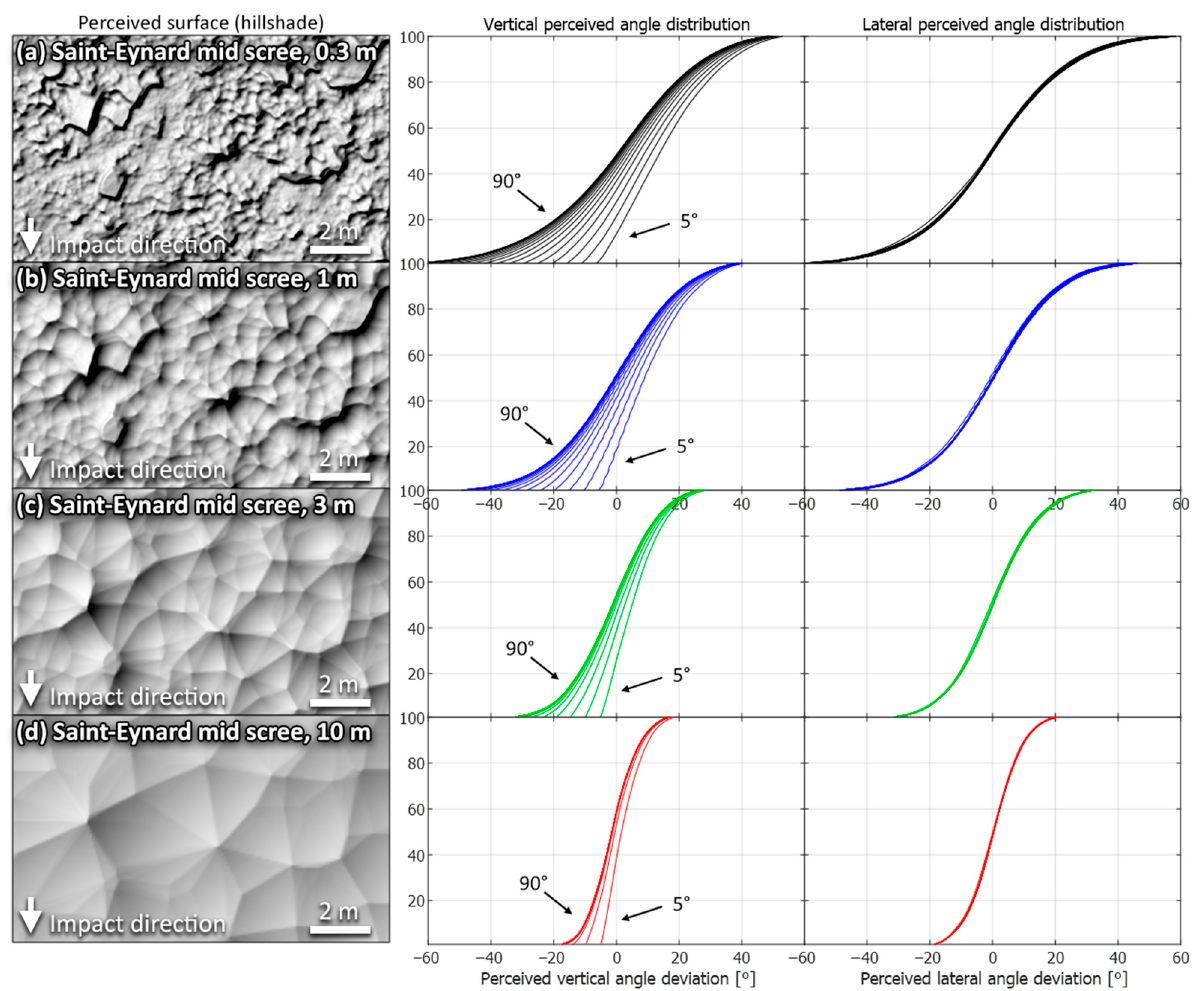
Figure 14. Vertical and lateral perceived deviation angles for the Saint-Eynard mid-scree site with four different impacting rock sizes (more than 60 million detected impacts summarized here). The left column shows how the rocks perceive the surface, with shaded top views of the sites. The middle column shows the vertical perceived deviation angles for the 18 incident angles (5° to 90° in 5° increments). The right column shows the lateral perceived deviation angles. The vertical axis of each graph corresponds to the centiles. The results for the 0.3, 1.0, 3.0 and 10 m wide impacting rocks are represented with black, blue, green and red lines, respectively.